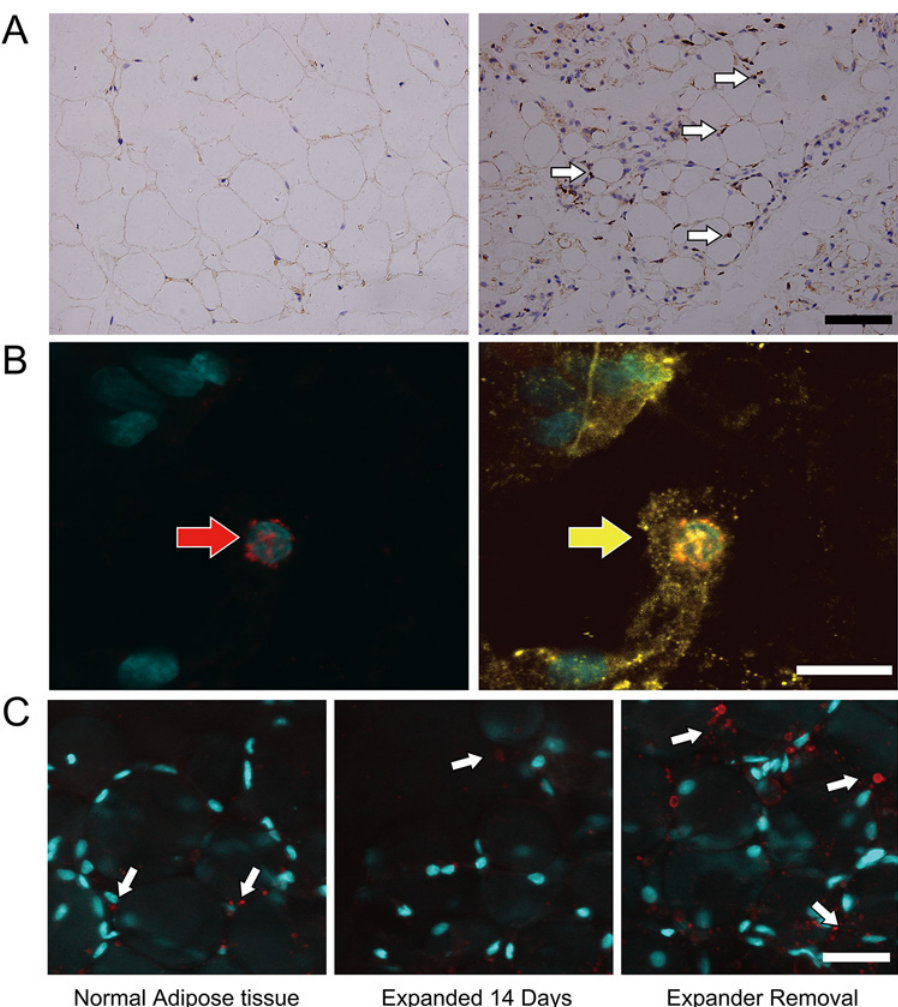
Fig 3. The proliferation and angiogenesis of the fat pad. A: The number of Ki67+ cells (white arrow) was increased during expension (day 0 left, day 14 right). Scale bar = 50 μ m. B: Some of the Ki67+ cells (red arrow) were also perilipin+ (yellow arrow). Scale bar = 10 μ m. C: The number of blood vessels (white arrow) did not decrease significantly, and when removing the expander, the angiogenic level increased. Scale bar = 25 μ